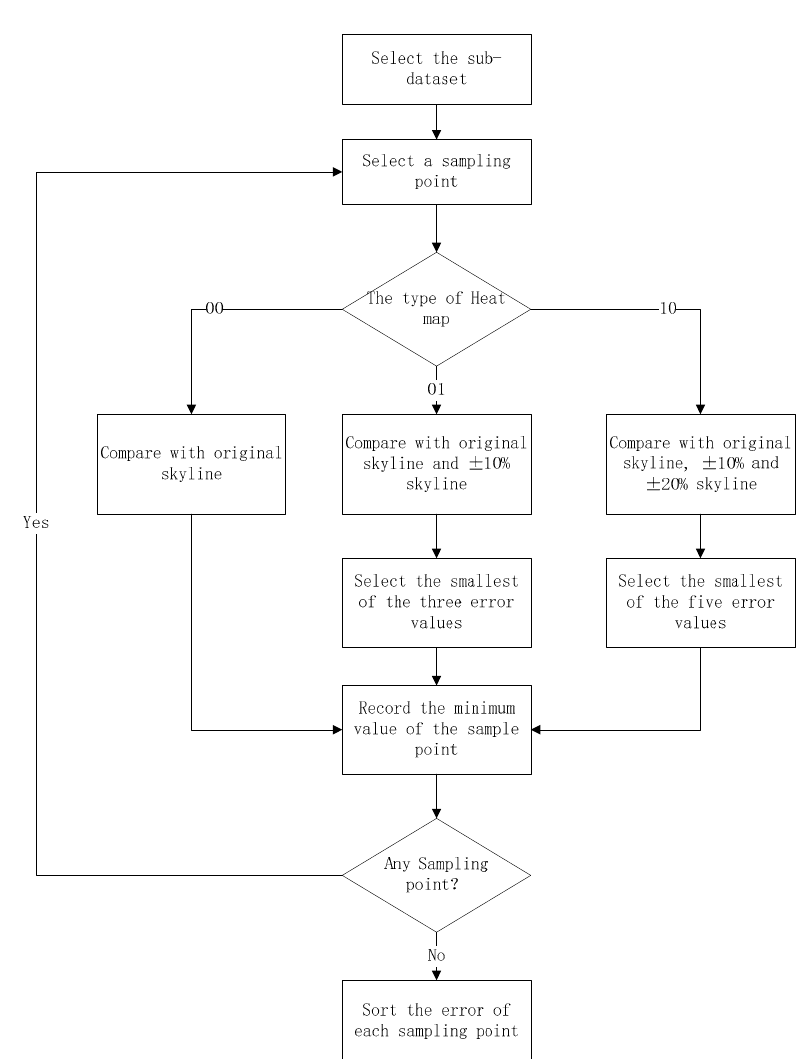
Figure 22. Flowchart of coarse matching.